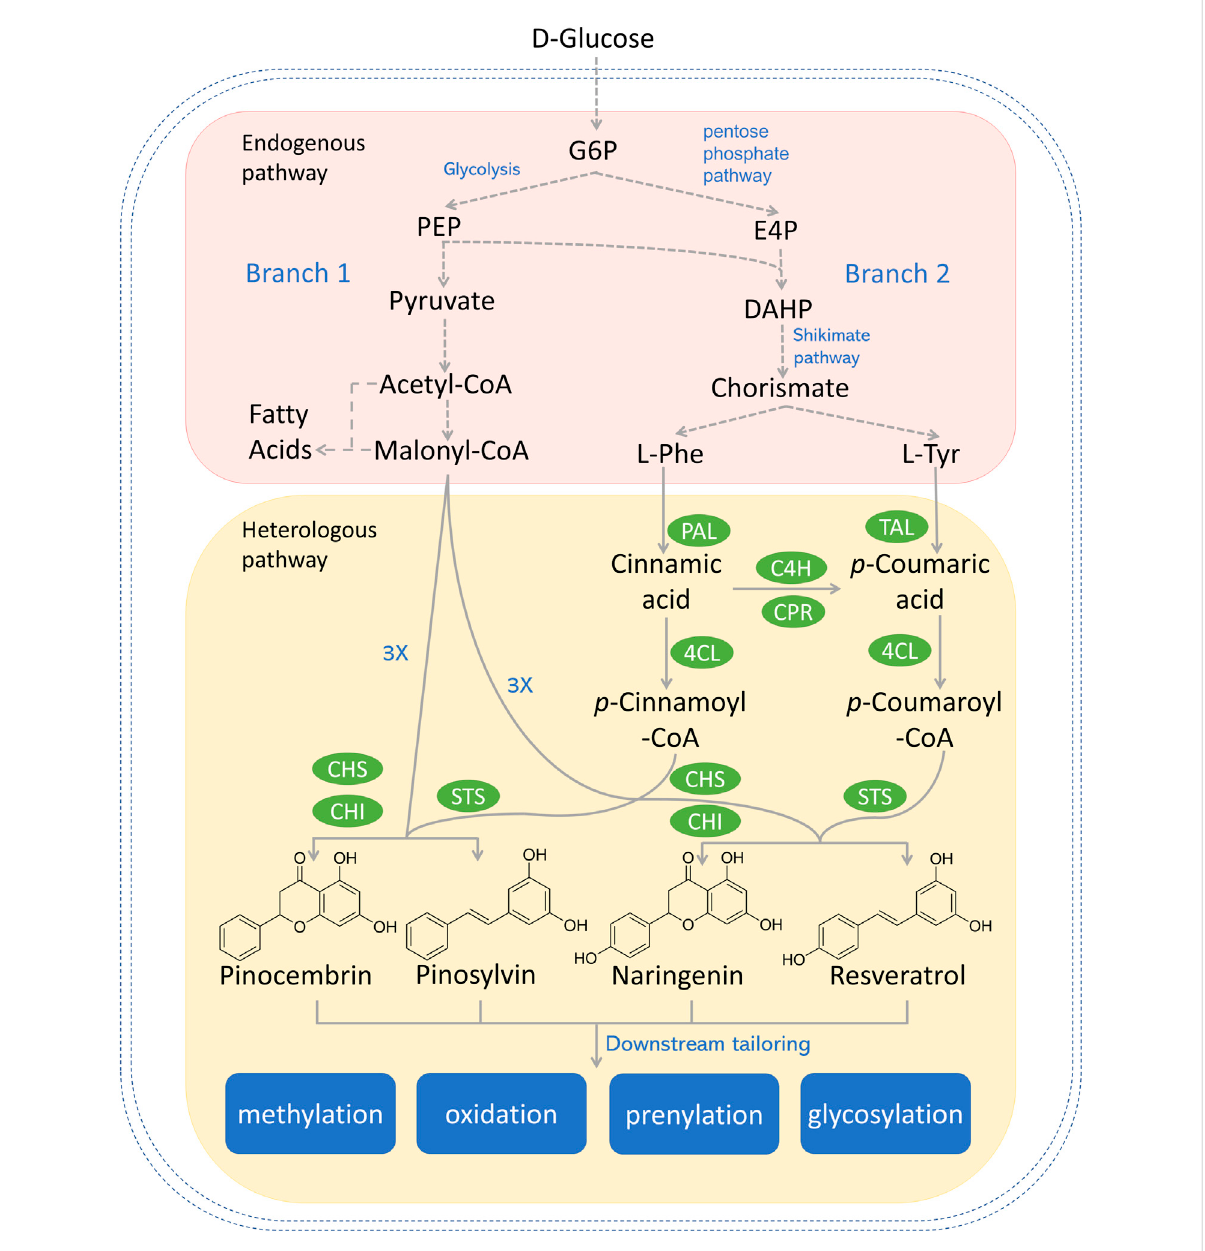
FIGURE 1 Reconstructed biosynthetic pathway for most explored type III PKS-derived polyketides (e.g., pinocembrin, pinosylvin, naringenin, and resveratrol) in microbial hosts. Dotted arrows refer to multiple steps. Genes and enzymes in green circle are heterologous genes from plants or bacterium. G6P, glucose-6-phosphate; PEP, phosphoenolpyruvate; E4P, erythrose-4-phosphate; DAHP, 3-deoxy-D-arabino-2-heptulosonic